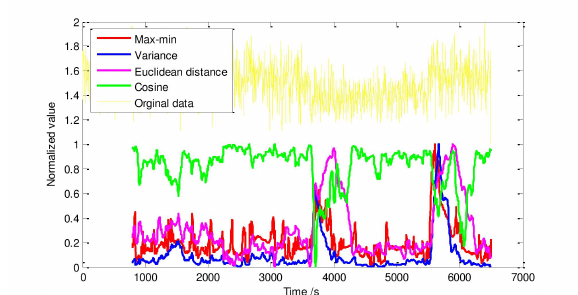
Figure 14. Detection example of subtle PU anomaly.